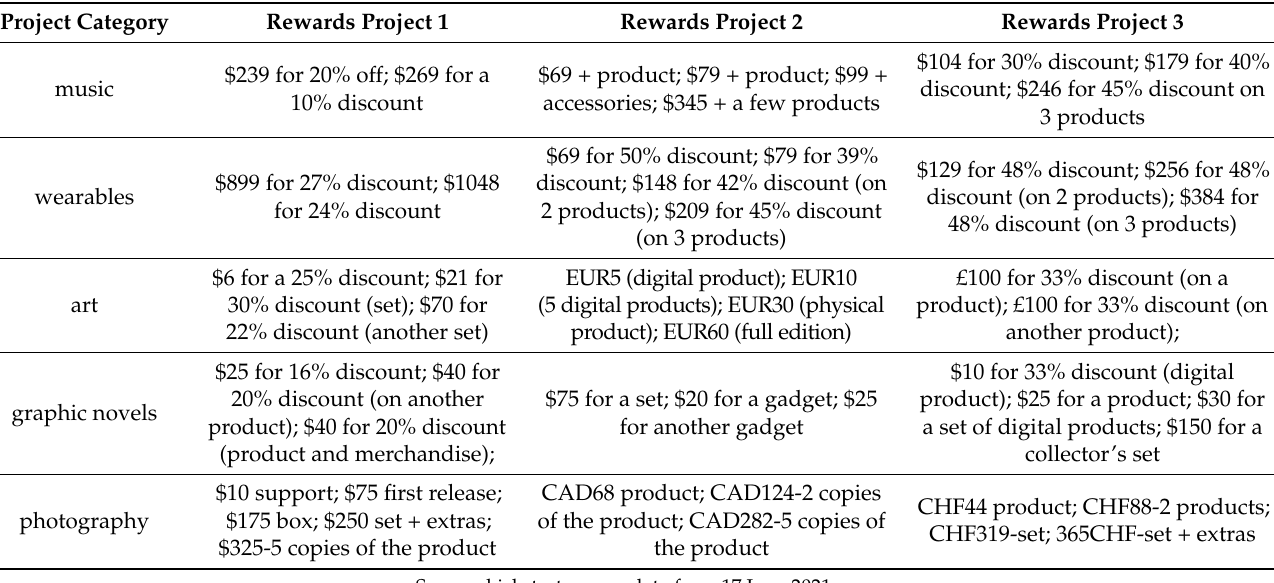
Table 2. Sample rewards for 3 selected projects in selected categories.